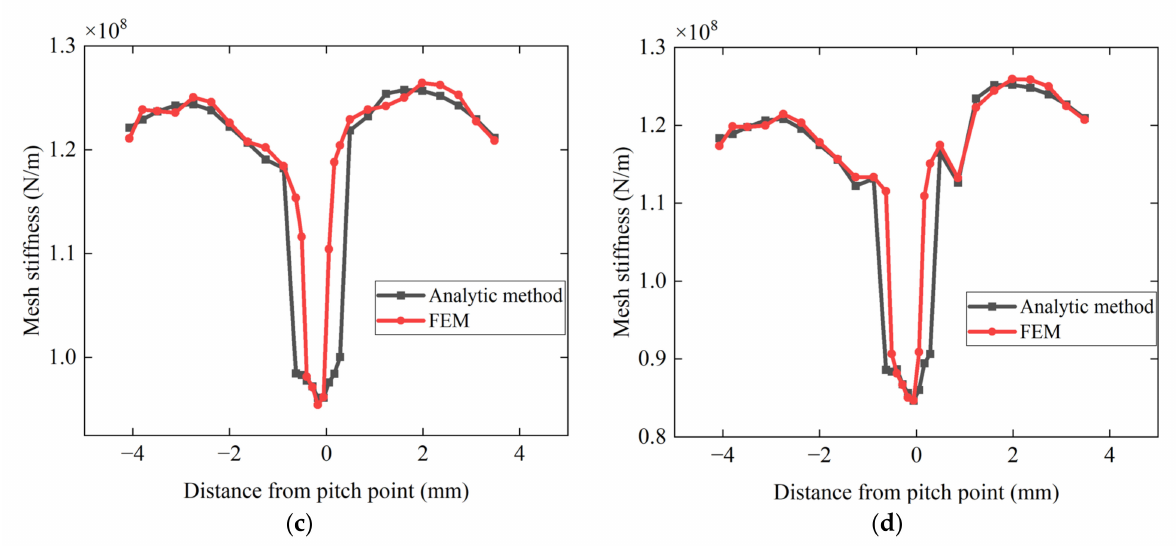
Figure 15. Comparison of stiffness calculation results: ( a ) Normal tooth condition; ( b ) Slight pitting and 0.5 mm crack condition; ( c ) Moderate pitting and 1 mm crack condition; ( d ) Severe pitting and 1.5 mm crack condition.